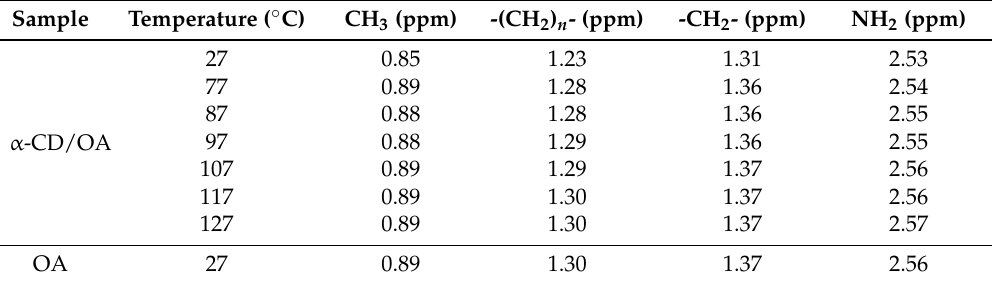
Table 2. Chemical shifts of pure OA and OA included in α -CD at various temperatures.